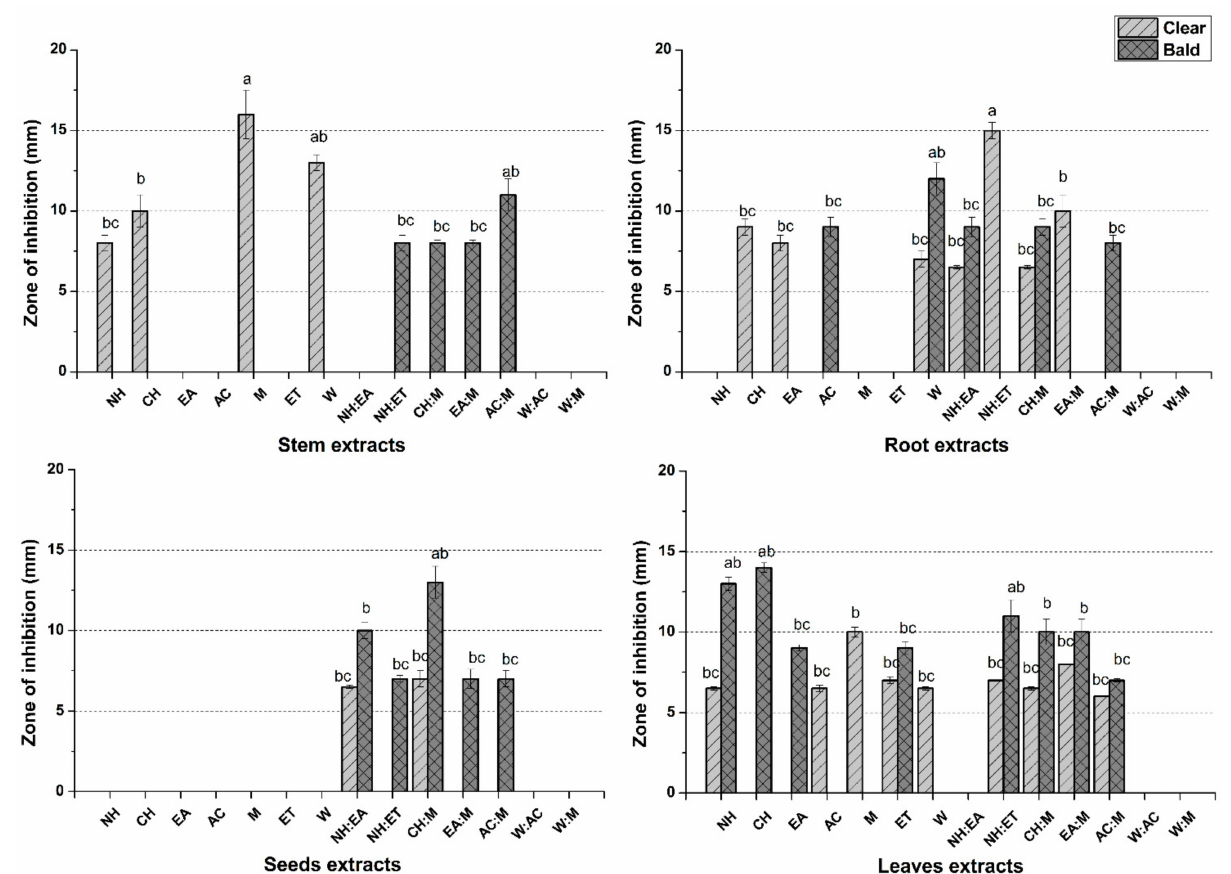
Figure 6. Protein kinase inhibitory activities of various solvent extracts of stem, seeds, leaves, and roots of P. glabrum . Positive control (surfactin at 20 µ g/disc) gave 33 ± 1.10 mm bald zone of inhibition. Values (mean ± SD) are the average of triplicate investigations. a − d means the difference is highly significant, slightly significant, and significant at p <